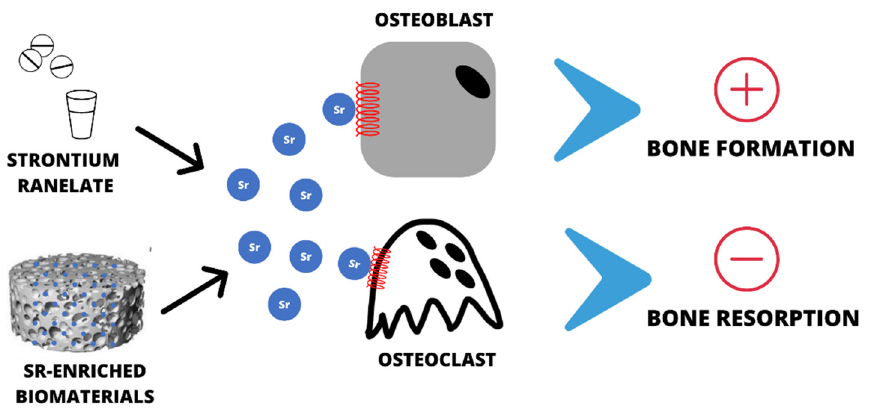
Figure 3. Different routes for administration of strontium ions.